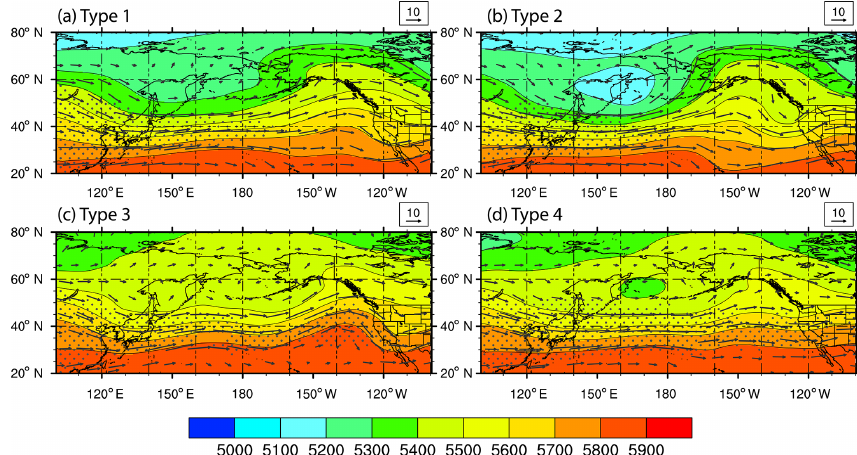
Figure 6. Geopotential height (gpm) and wind vectors (ms − 1 ) at 500hPa in each of the four SOM types in WRF-Chem. The dotted regions indicate DOD higher than 0.03 from